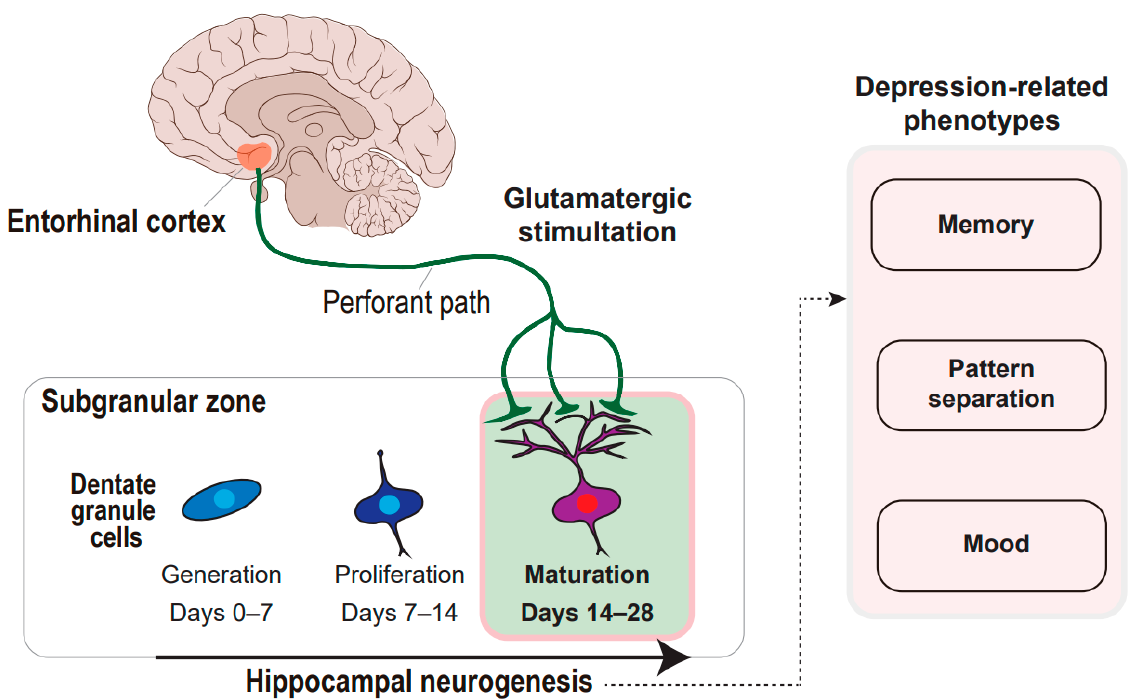
Figure 1. Concept framework of entorhinal cortex-regulated hippocampal neurogenesis in the regulation of depression- related phenotypes. The glutamatergic stimulation from the entorhinal cortex through the perforant paths to the subgranular zone of the hippocampal dentate gyrus is deciphered. The glutamatergic stimulation prompts the maturation of the dentate granule cells during hippocampal neurogenesis, which can regulate memory, pattern separation, and mood.